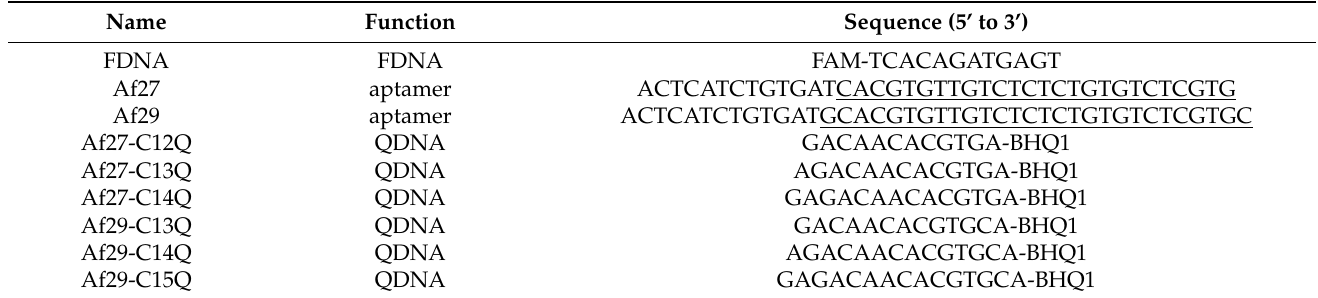
Table 1. Sequences of different DNA